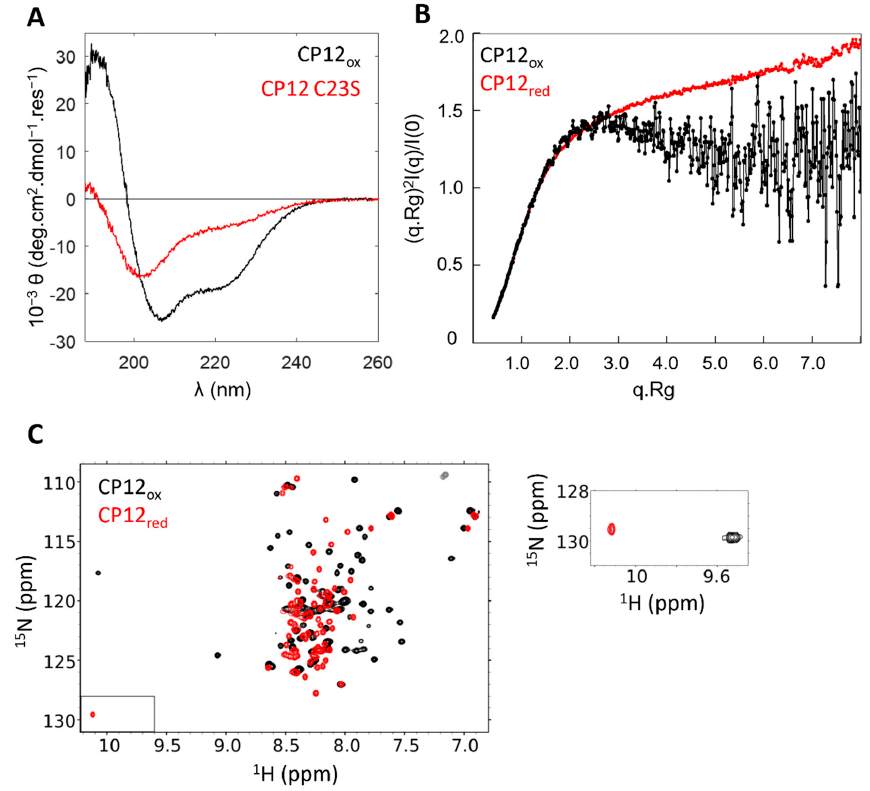
Figure 4. Biophysical analysis of CP12 confirmed that CP12 is an IDP. ( A ) Circular dichroism spectra of 10 µM recombinant C. reinhardtii oxidized CP12 (black), and of a CP12 mutant lacking the N- terminal disulfide bridge (mimicking reducing conditions, red). ( B ) Normalised Kratky representation of the SAXS data of the oxidized (black) and reduced (red) form of recombinant C. reinhardtii CP12. ( C ) NMR 1 H- 15 N-HSQC spectra of the oxidized (black) and reduced (red) form of recombinant C. reinhardtii CP12. The box between 9.5 and 10 ppm corresponds to the insert shown on the left. CP12 is not the unique protein that undergoes structural transitions upon oxida- tion/reduction, and it is predicted that redox-sensitive CDPs are widespread and have key